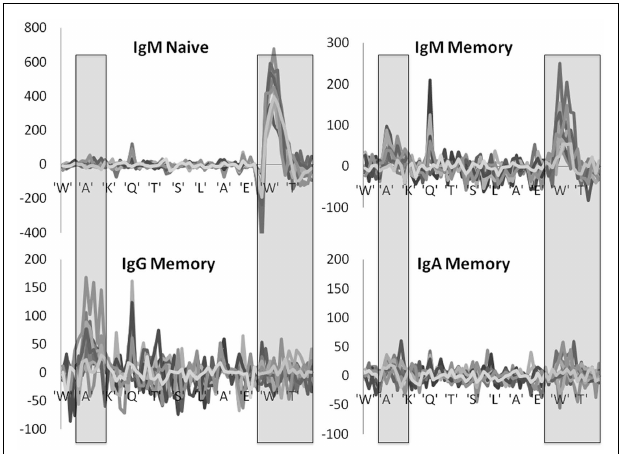
FIGURE 4 | Position specific effects .Total LONR score per amino acid (averaged over the 3-nt composing the amino acid).The LONR is drawn for the four isotypes discussed in previous figures: naïve IgM, memory IgM, IgG, and IgA. Each line represents a different donor.The highlighted regions represent the CDR2 (to the left) and CDR3 (to the right).The sequence at the bottom is a typical sequence.The zone of very strong negative selection at the beginning of the CDR3 is the junction region. One can observe a switch from a very strong positive selection in the naïve IgM isotype focused on the CDR3 to a much weaker selection in the IgG and IgA focused on the CDR2. Note that the scales of the y axes are different between the plots.